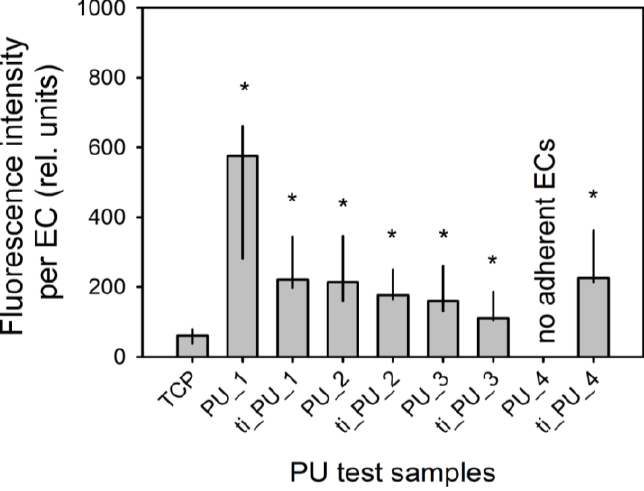
Figure 4. Activation of endothelial cells (EC) cultured on different PUs. ECs ( n = 8) were cultured for 7 d (Figure 2), and incubated with Calcein-AM-stained PBMCs as described